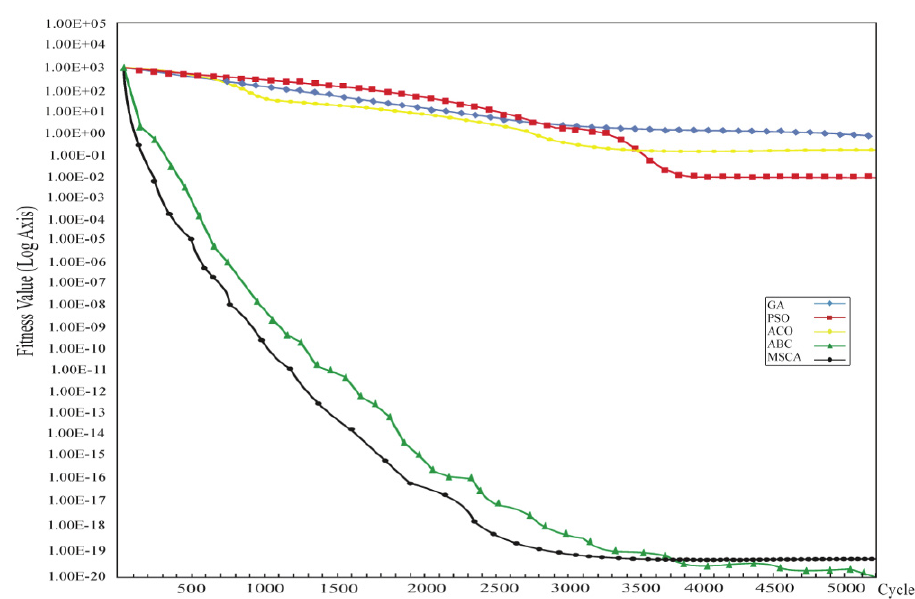
Figure 2. The results of applying different algorithms on Sphere function.